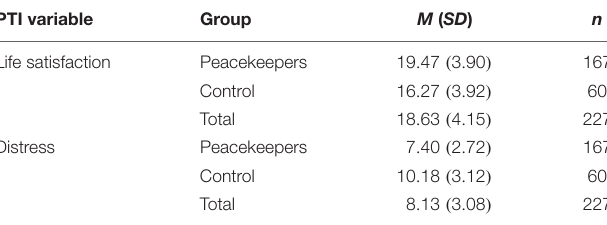
TABLE 4 | Means (SDs) of the quality of life by peacekeepers and control